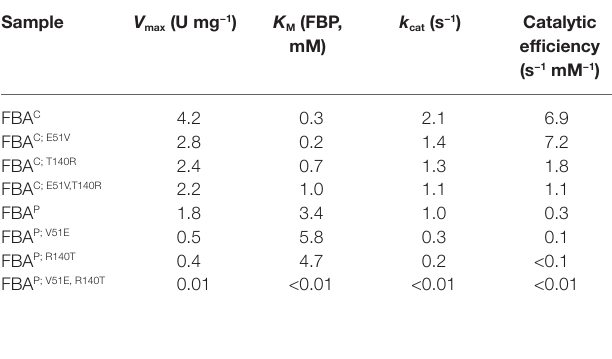
TABLE 1 | Kinetic parameters [fructose-1,6-bisphosphate (FBP) cleavage] of native FBAs and site-directed mutagenesis (SDMs) in glycolysis. Sample